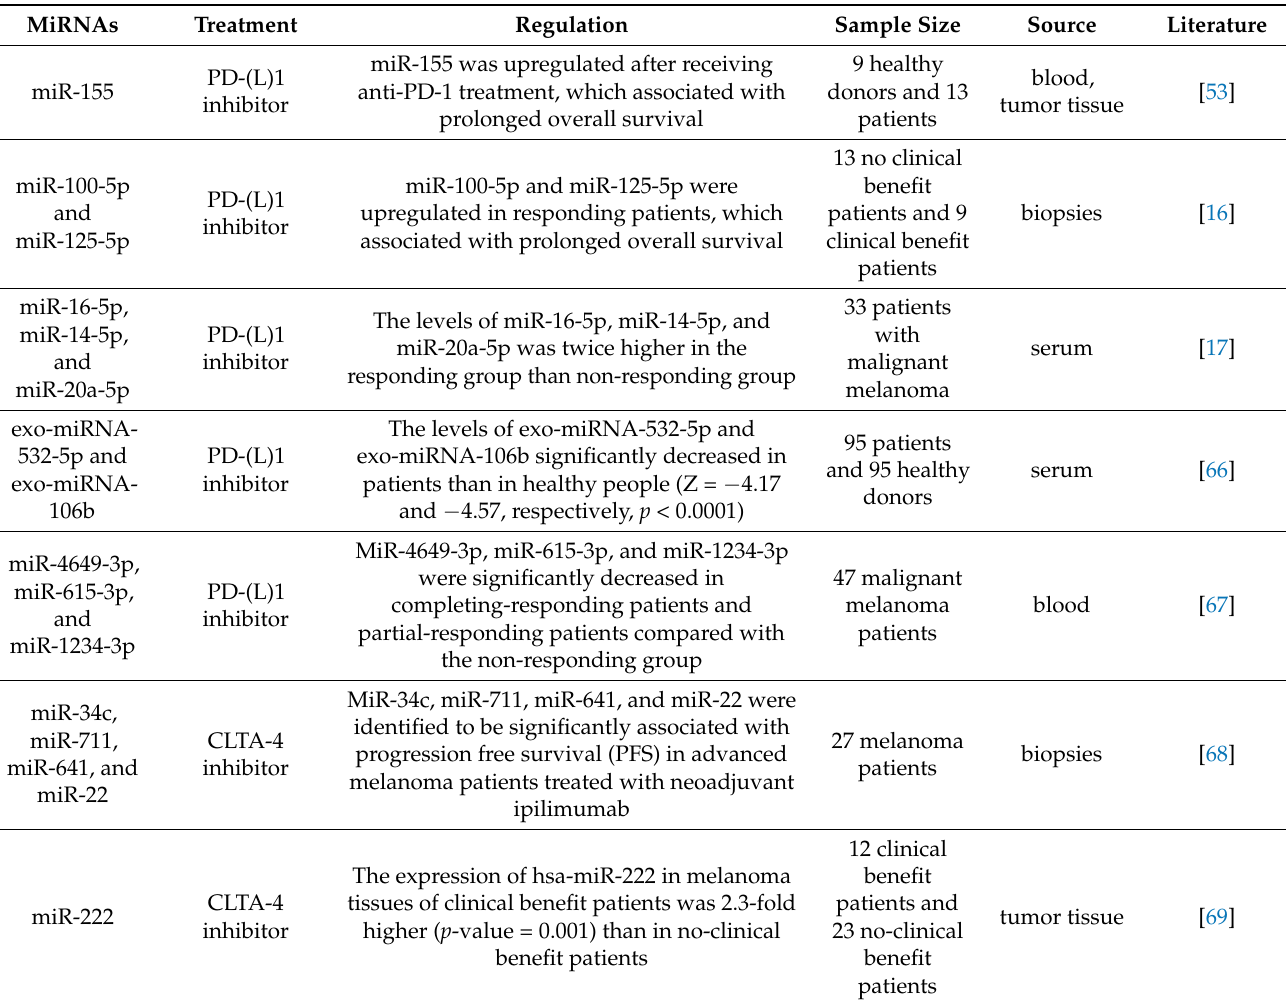
Table 2. Regulation of miRNAs in immunotherapy of PD-(L)1 inhibitor/CLTA-4